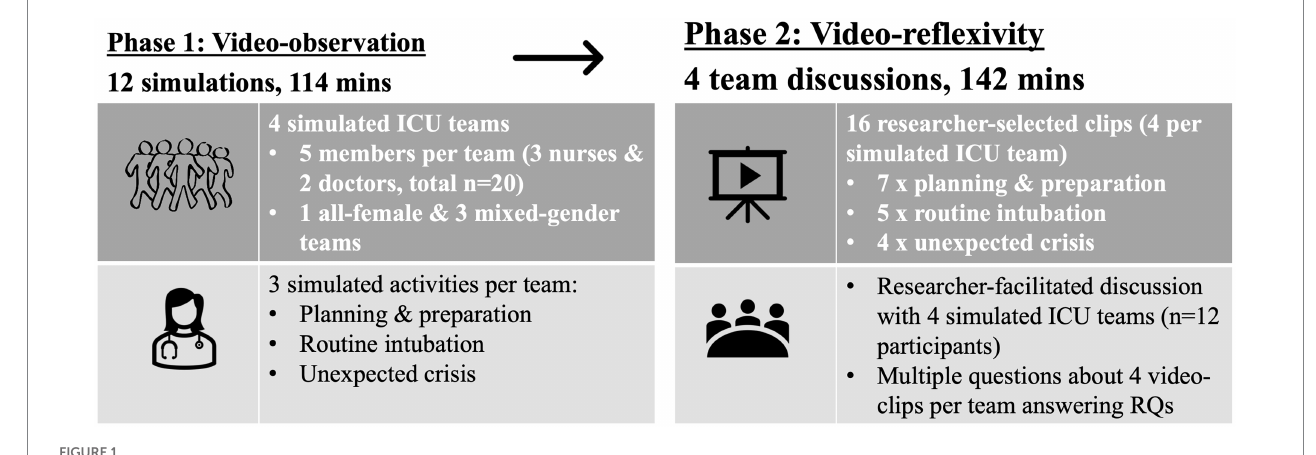
FIGURE 1 Overview of data